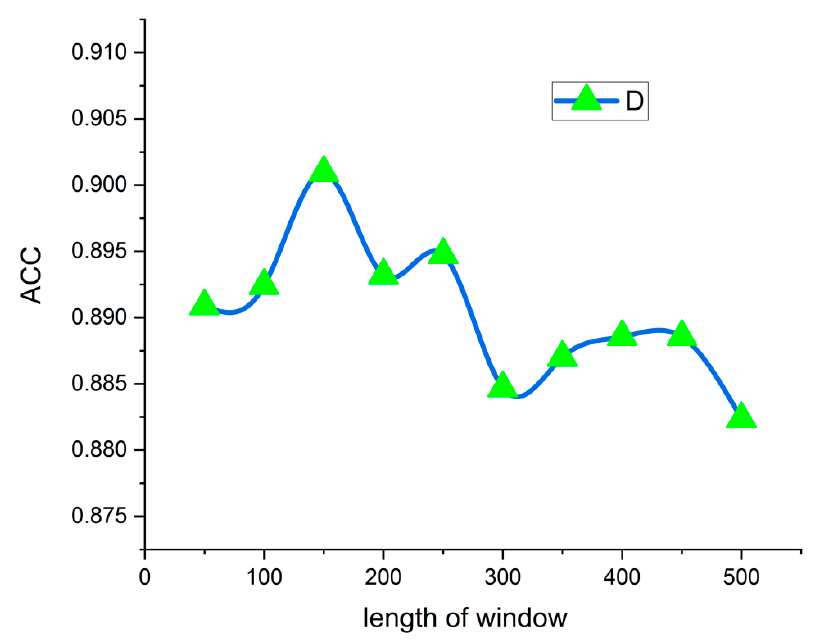
Figure 5. Influence of short-time Fourier transforms (STFTs) with different window lengths on ACC.